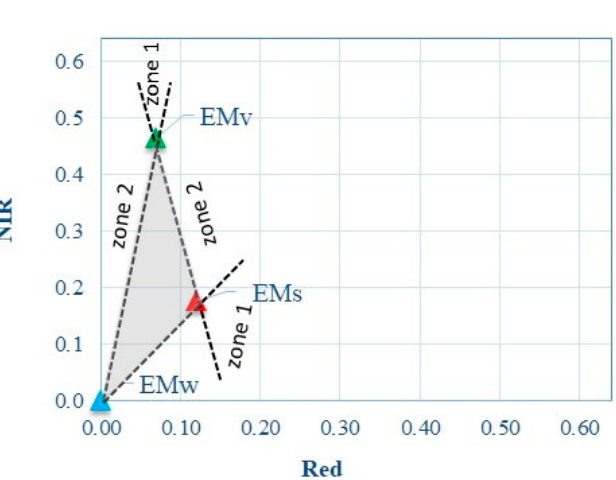
Figure 5. An illustration of a translated pixel cloud triangle in the 2-dimensional spectral mixing space constructed by the red and NIR band. EM V , EM S , and EM W represent the endmembers of vegetation, bare soil/litter, and water, respectively.